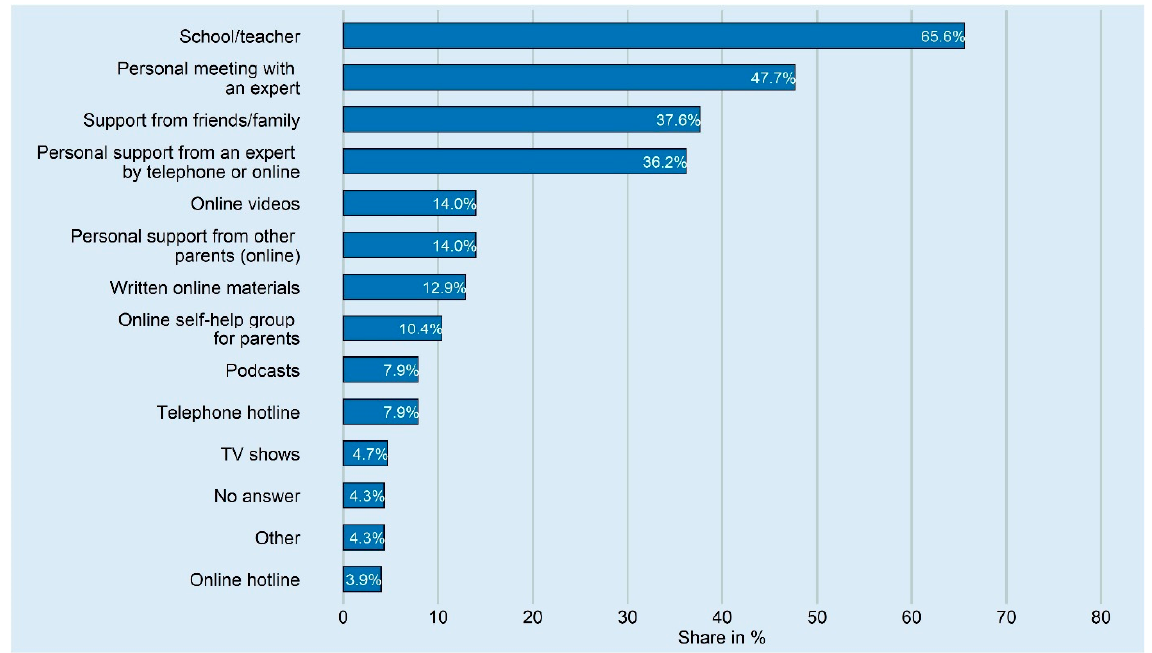
Figure 2. Information on how, or from whom, parents would like to receive support in dealing with their children during the COVID-19 pandemic. Indicated is the share of parents who answered that they always/rather often/occasionally needed support ( n = 279).